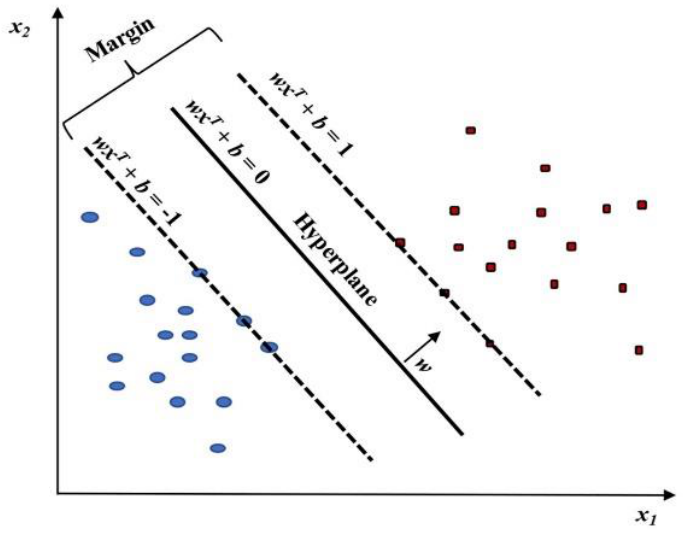
Figure 3. The structure of hyperplane’s margin for